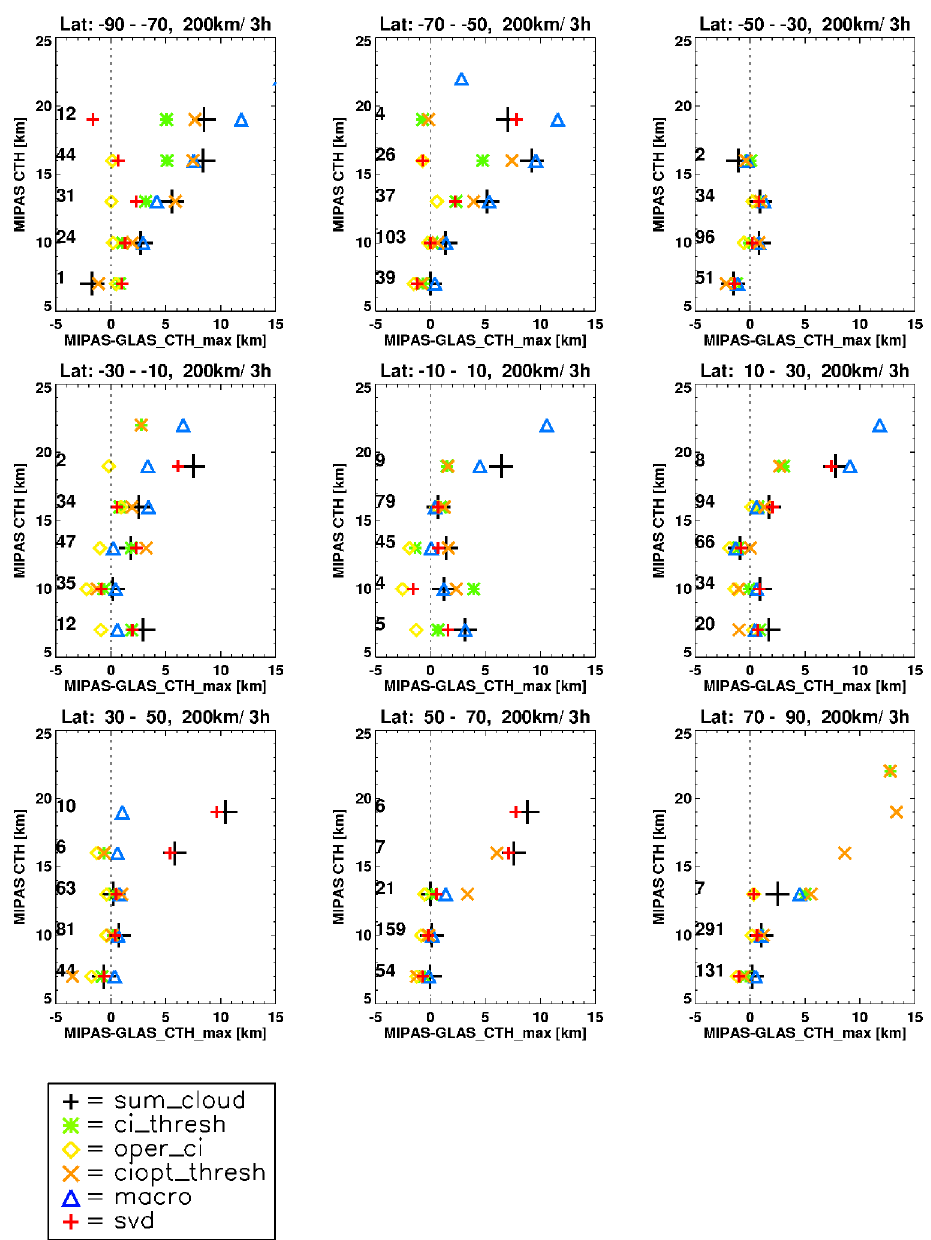
Fig. 18. Altitude-binned differences of cloud top heights between the various MIPAS detection methods and the GLAS lidar co-incidences (200km/3h). Black number represents the number of both-cloudy events for the parameter SUM